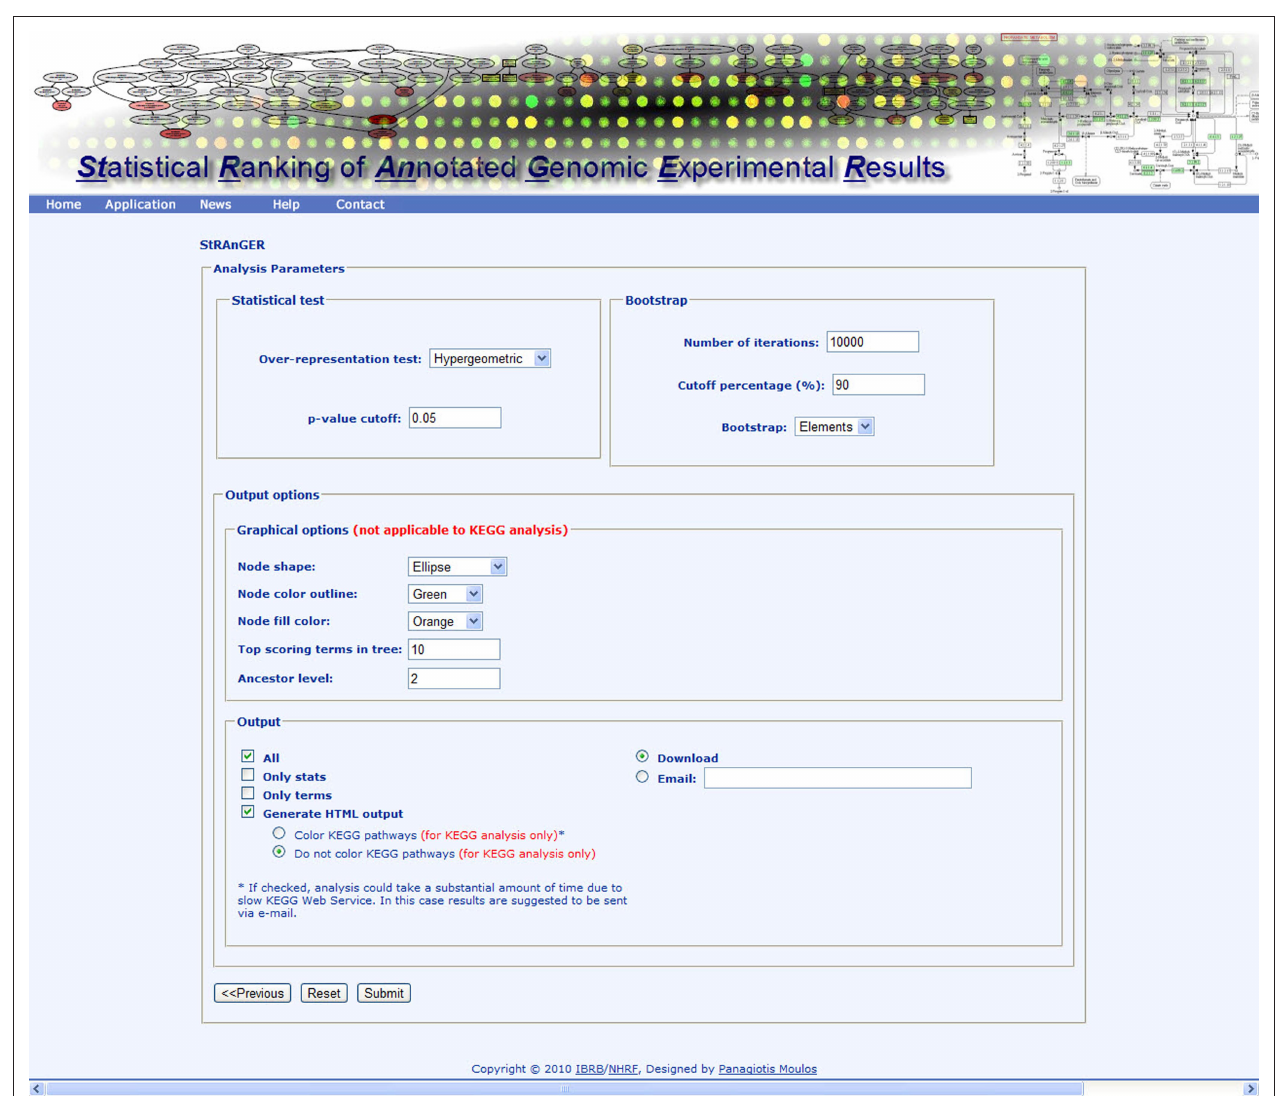
Figure 3 | instance of the StrAnger application web interface depicting various parameters of the StrAnger algorithm and the tree